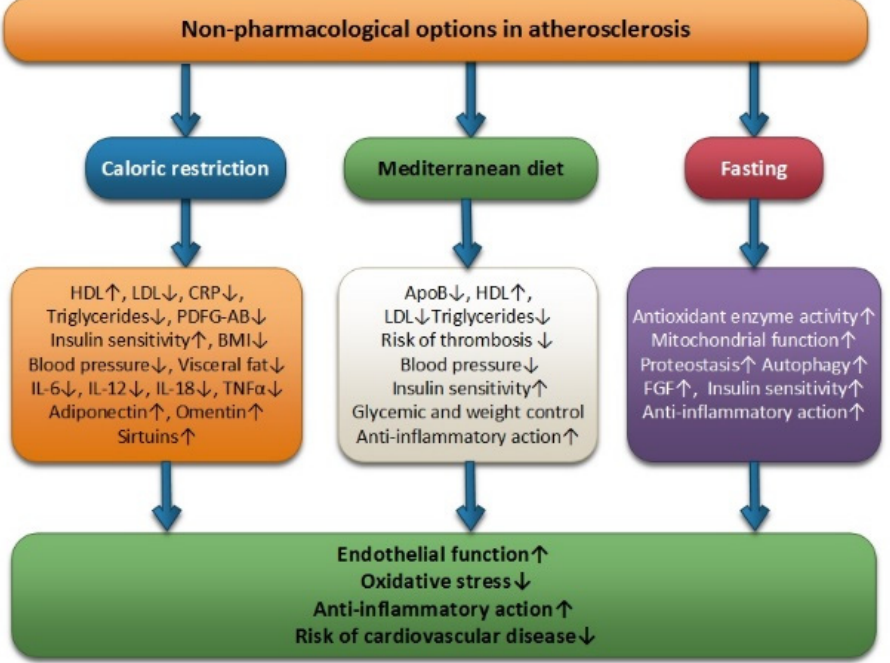
Figure 1. Non-pharmacological options in atherosclerosis: caloric restriction, Mediterranean diet and fasting.